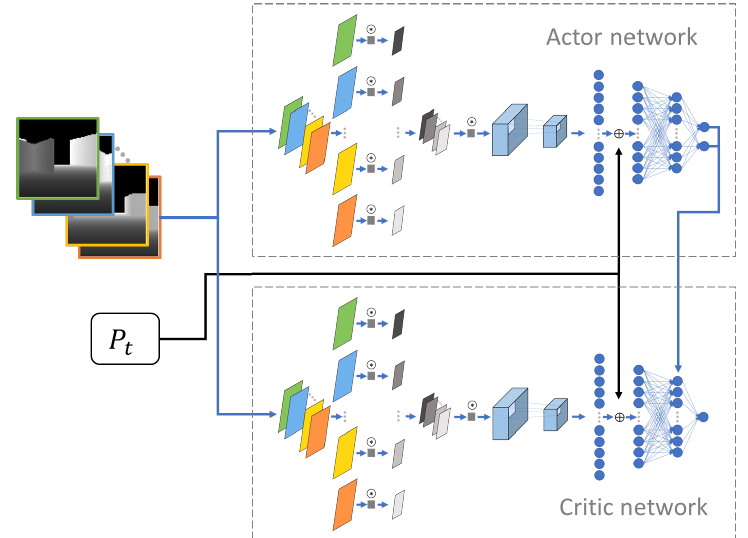
Figure 2. Full architecture of the proposed network including the actor and critic parts. Both parts of the network use the same depth and position information as state inputs. The calculated actions from the actor are sent to the critic to update the network parameters. (cid:126) and ⊕ denote convolution and concatenation,